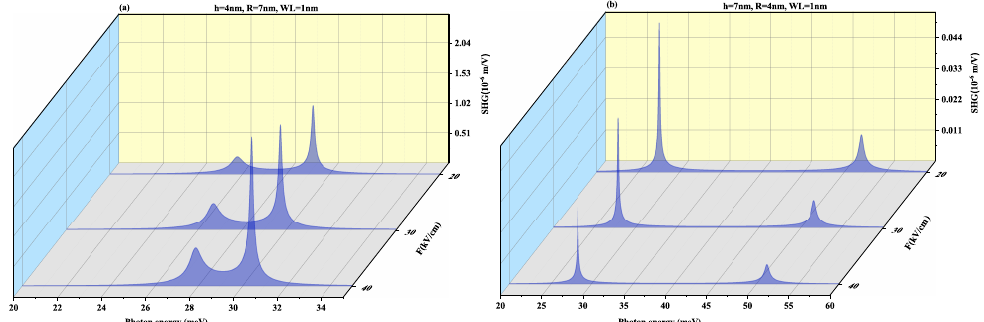
Figure 10. Second harmonic generation as a function of the photon energy for ( a ) oblate height R = 4 nm with radius R = 7 nm at WL thickness 1 nm ( b ) prolate QD with R = 4 nm, h = 7 nm with WL thickness = 1 nm for different values of lateral electric field F = 20,30 and 40 kV/cm.